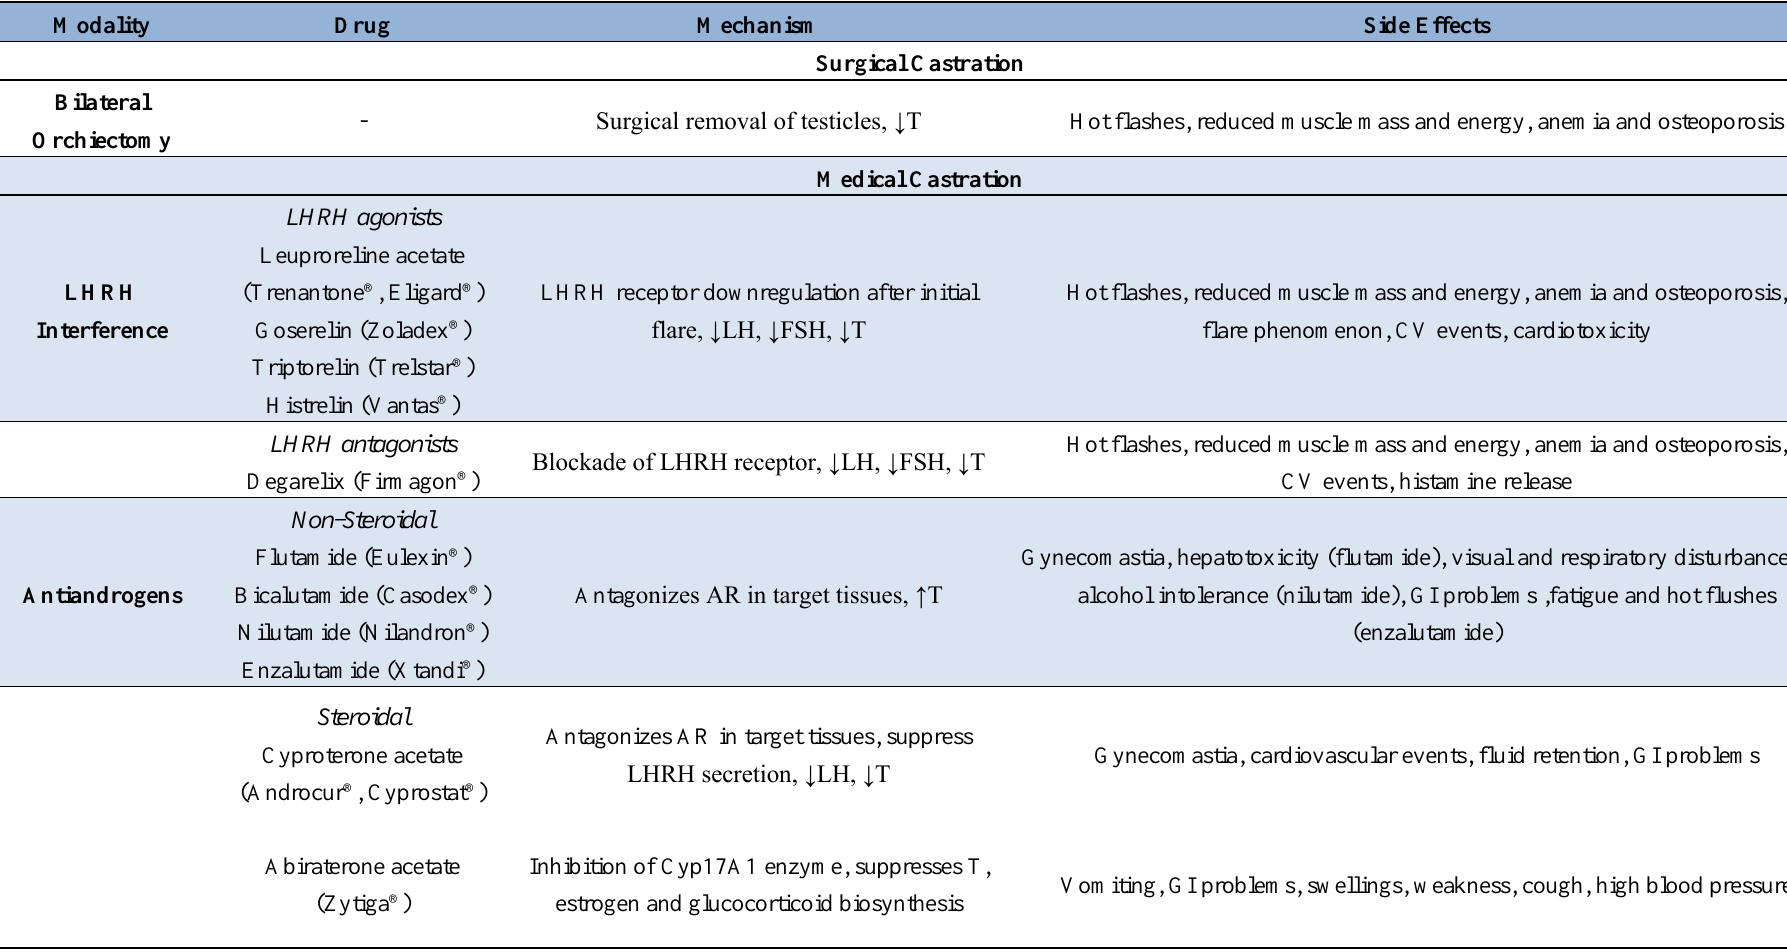
Table 1. Treatment options for hormone